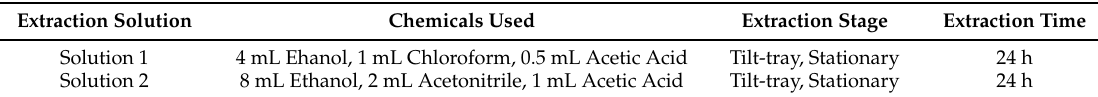
Table 2. Summary of the type of extraction solutions used and the parameters tested for each solution.